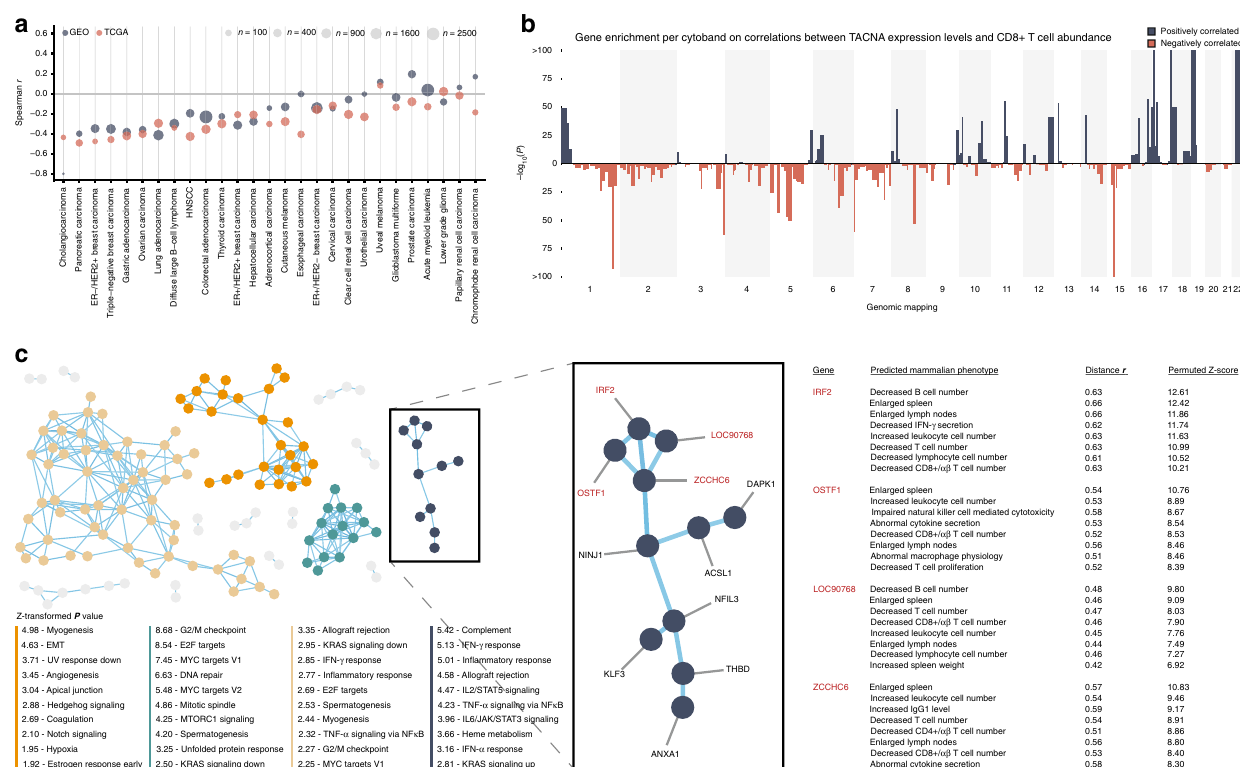
Fig. 6 Transcriptional effects of CNAs in relation to inferred immunological phenotypes. a Per tumor type, Spearman correlations between inferred CNA burden and an expression-based metric describing CD8 + T cell activity for each sample. b Manhattan plot showing, the enrichment ( − log 10 P value on the y -axis) for genes with a strong correlation between TACNA expression level and inferred CD8 + T cell abundance per cytogenetic band de fi ned according to the MSigDB Positional gene sets collection. c Left panel: constructed co-functionality network for the top 350 genes with the highest inverse correlation between their TACNA expression levels and CD8 + T cell abundance. Middle panel: cluster in which genes share strong predicted co-functionality ( r > 0.8) within the co-functionality network that was enriched with genes predicted to be involved in immunological processes (e.g., complement, in fl ammatory response, and IFN- γ response). Right panel: a GBA strategy with >106,000 expression pro fi les in combination with the gene set collection obtained from the Mammalian Phenotype (MP) Ontology predicted for the genes IRF2 , OSTF1 , LOC90768 , and ZCCHC6 that altered transcription results in a decreased CD8 + / αβ T cell